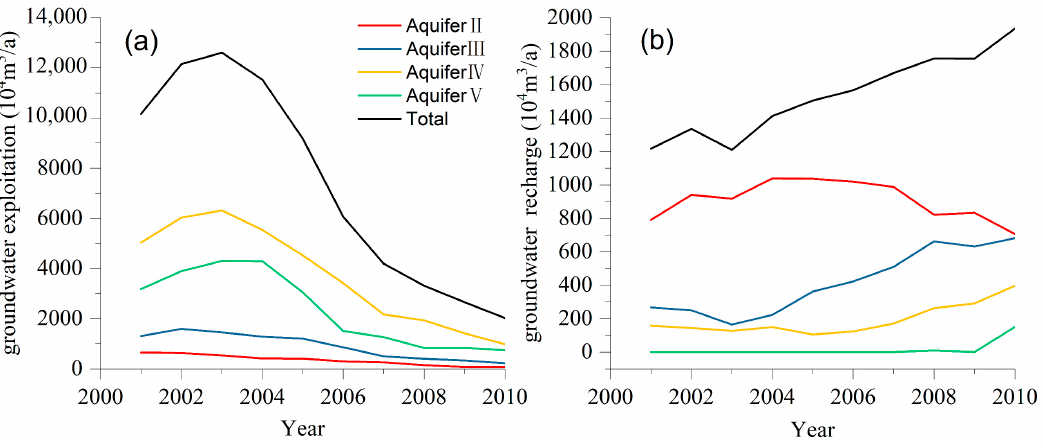
Figure 5. Groundwater exploitation ( a ) and recharge ( b ) in di ff erent aquifers in Shanghai 2001–2010. Table 6. Groundwater exploitation and recharge in di ff erent Shanghai districts and aquifers in 2010. Aquifer II Aquifer III Aquifer District